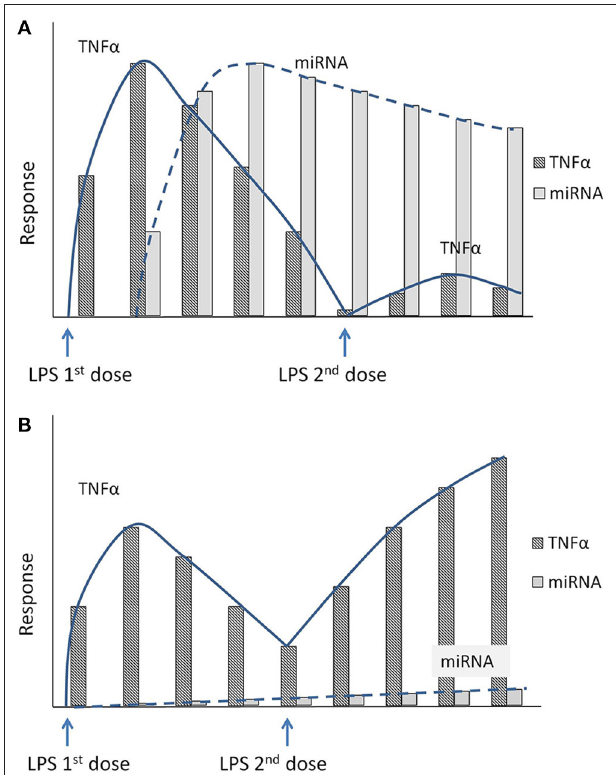
FIGURE 3 | (A) Hypothetical figure illustrates the inflammatory response to repeated LPS exposure. Exposure to the first dose of LPS increases the proinflammatory marker TNF α . Shortly following the initial dose of LPS, the cells also secrete specific anti-inflammatory miRNAs that accumulate in the cytoplasm. Upon exposure to second dose of LPS, the sustained high levels of the anti-inflammatory miRNAs will blunt the inflammatory response with decreased TNF α levels (endotoxin tolerance). (B) Hypothetical figure illustrates the inflammatory response in the absence of the anti-inflammatory miRNAs mediated endotoxin tolerance. In a knockout model of specific miRNA, the miRNA levels do not increase after initial exposure to LPS. A